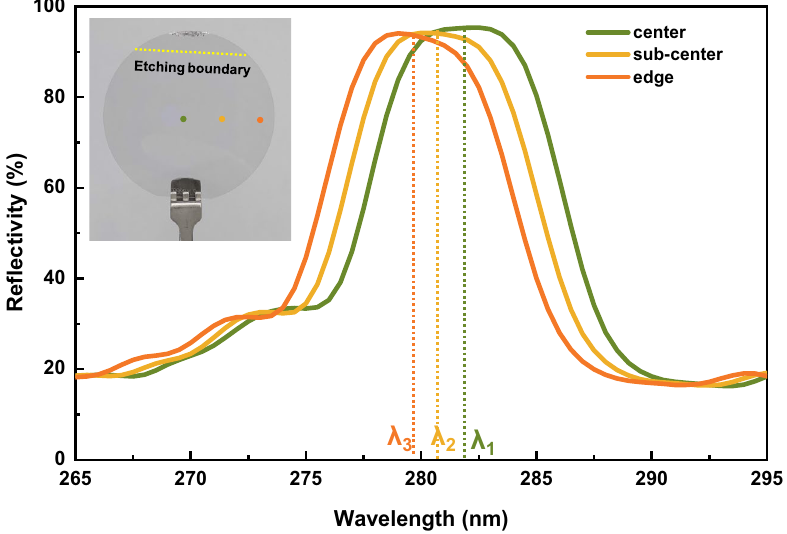
Figure 2. Reflectivity spectra of the 2-in. DBR wafer prepared at 25 V and 65 °C, the inset shows the photo of the